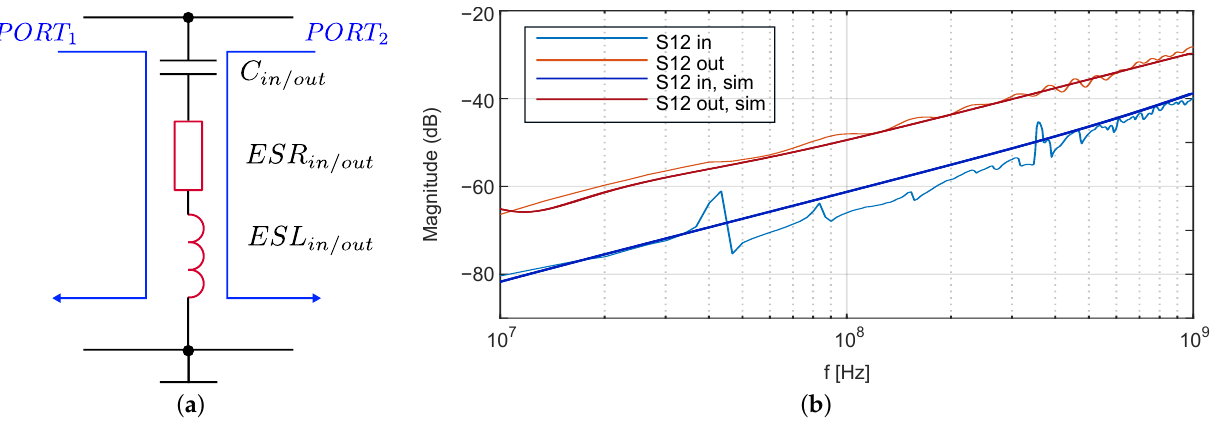
Figure 14. S12 measurements of the in- and output capacitors to estimate the ESL in / out . ( a ) Measure- ment setup for the S12 measurement of the in- and output capacitors. ( b ) S12 measurement of the in- and output capacitors.